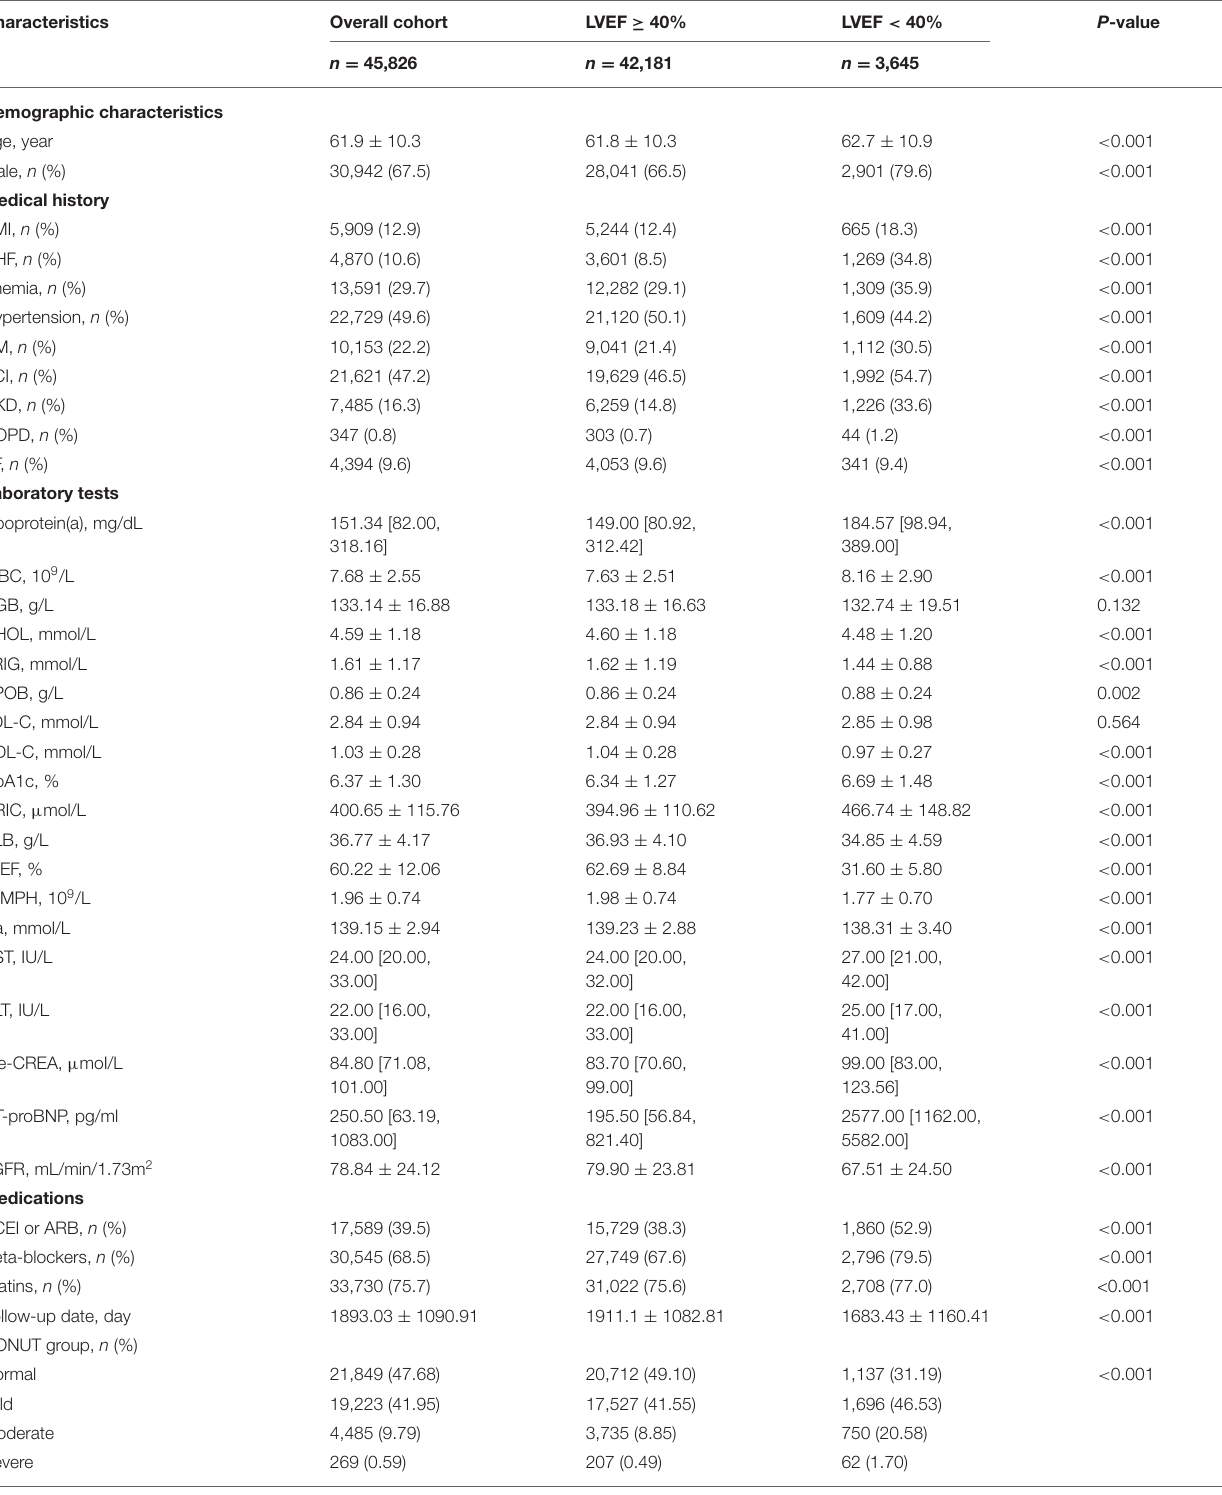
TABLE 1 | Baseline characteristics of study patients across LVEF categories.